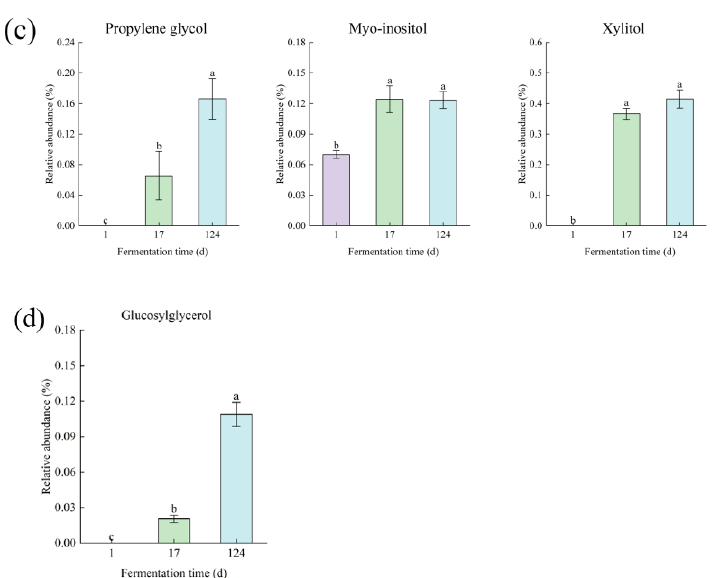
Figure 2. Metabolite changes in ( a ) sugars, ( b ) organic acids, ( c ) polyols, and ( d ) glycoside of edible grass during fermentation. The bars with different letters indicate significant differences ( p < 0.05).